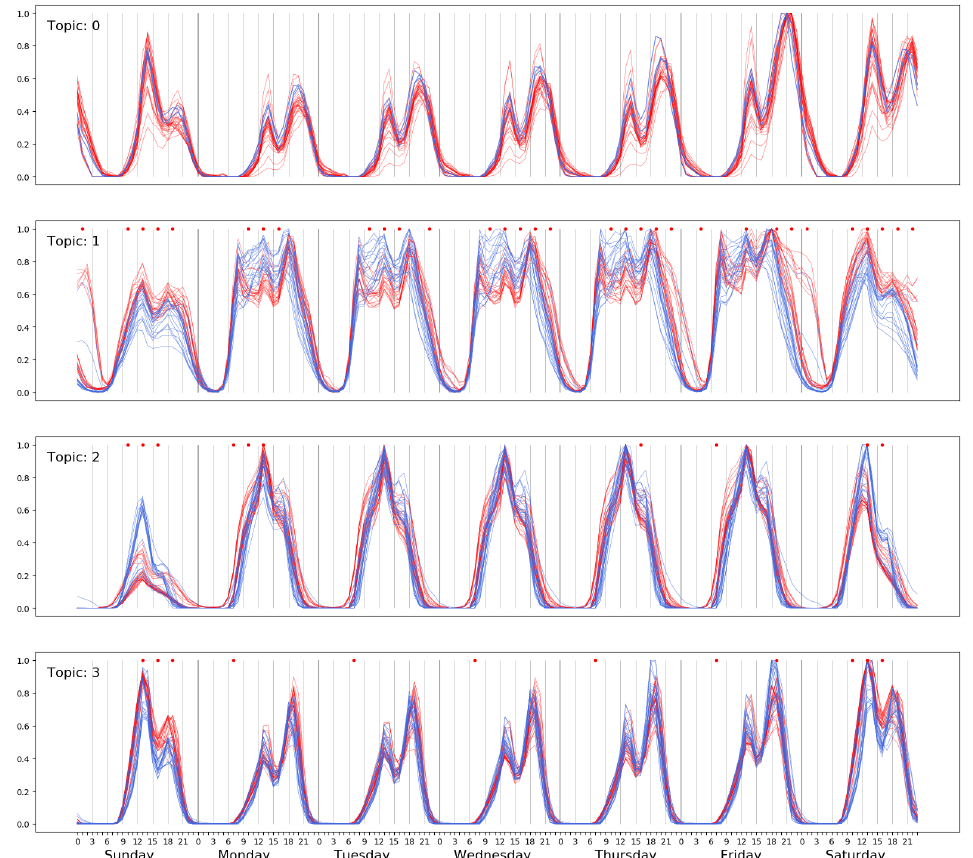
Figure 8. Change in activity topics due to the lockdowns and curfews imposed to curb the pandemic. Dark blue and red lines correspond to topics extracted from data of 2020 and 2019, respectively. The red dots denote statistically significant ( p < 0.0001) differences among pre-pandemic and pandemic activity topics in aggregations of 3